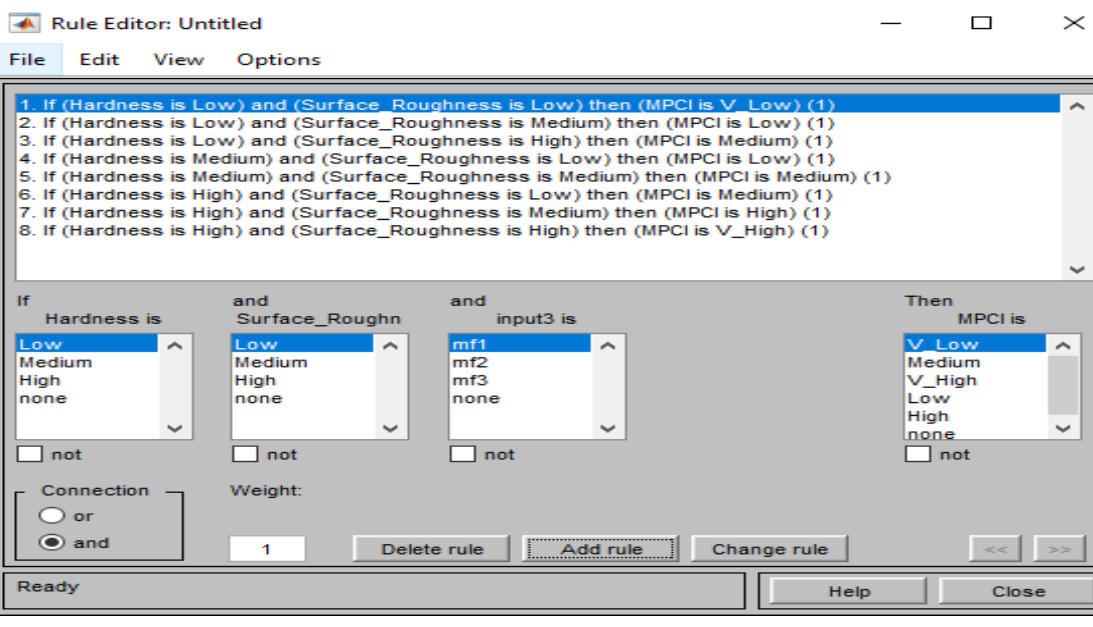
Figure 10. Rules editor.